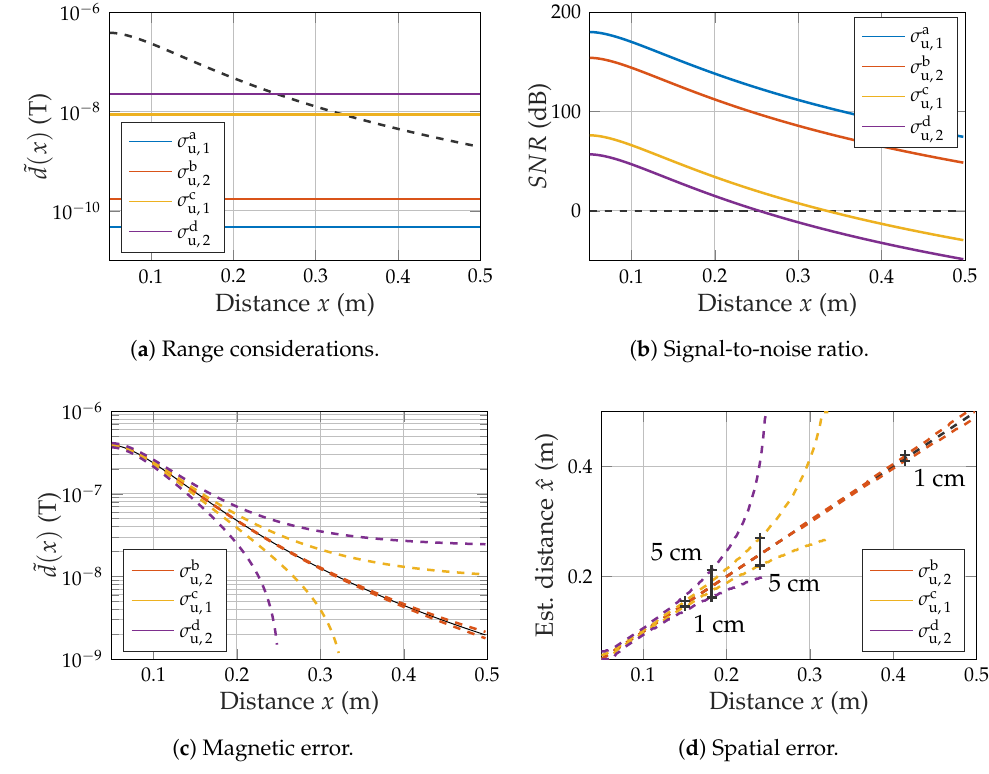
Figure 10. Performance metrics based on